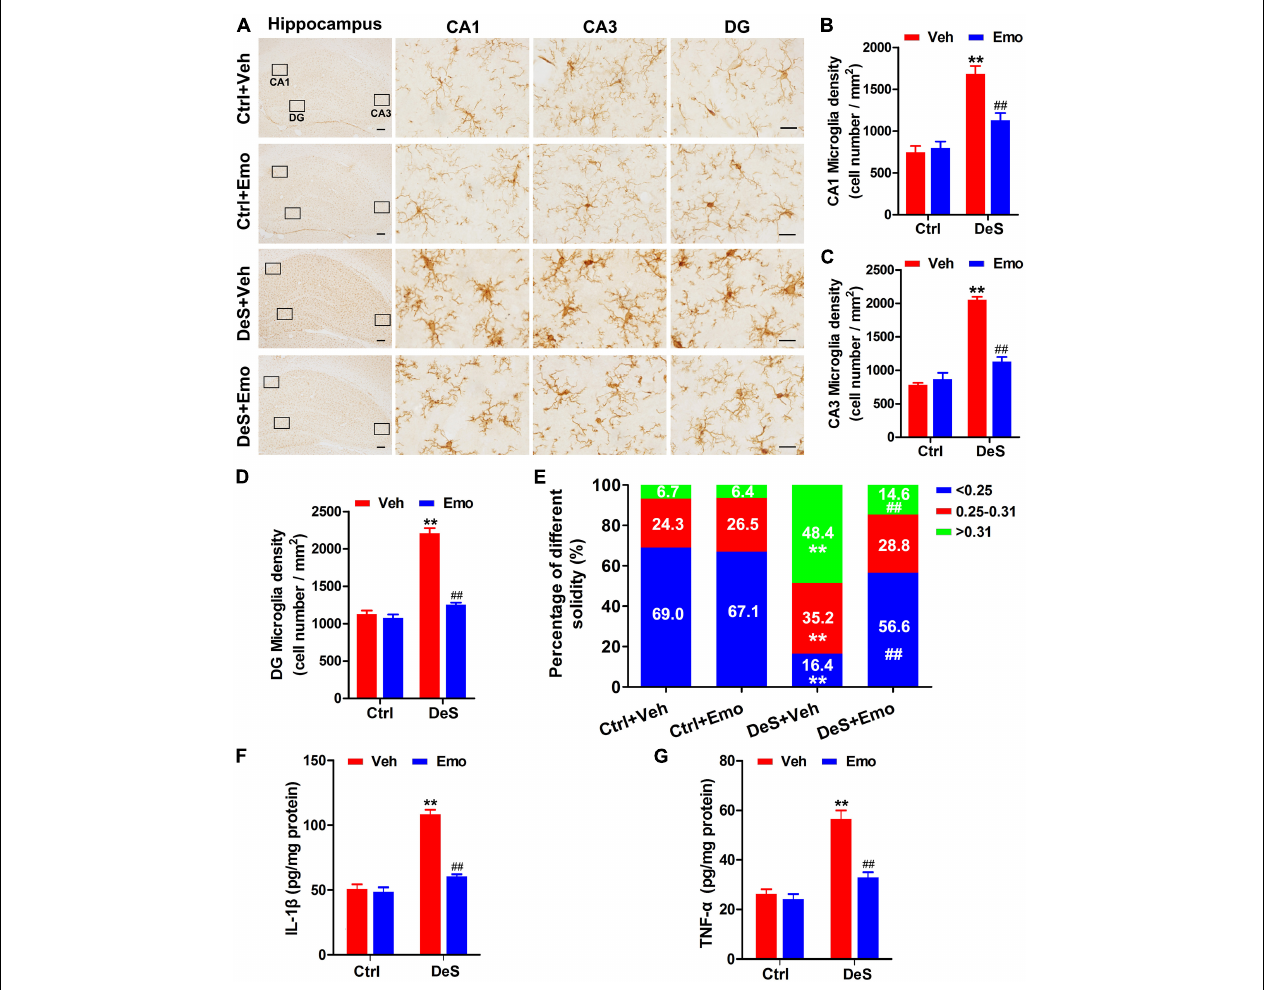
FIGURE 5 | Depression associated microglia activation was inhibited by emodin. By immunohistochemistry staining with Iba1 (a marker of microglia), hippocampal microglia were shown (A) (left scale bar = 200 µ m, right scale bar = 20 µ m). The densities of microglia in CA1 (B) [ F ( 3 , 8 ) = 27.088, p = 0.000], CA3 (C) [ F ( 3 , 8 ) = 82.790, p = 0.000] and DG (D) [ F ( 3 , 8 ) = 13.656, p = 0.000] regions were calculated ( n = 3 brains/group). The solidity value analysis was used to evaluate the activation of microglia. Higher solidity value indicated higher activity of microglia. The solidity values of the microglia were divided into three grades ( < 0.25, 0.25–0.31, > 0.31), and the percentages of microglia with different grades in different groups were shown ( E , n = 3 brains/group). By ELISA, hippocampal levels of interleukin-1 β (IL-1 β , F ) [ F ( 3 , 8 ) = 34.317, P = 0.000] and tumor necrosis factor- α (TNF- α , G ) [ F ( 3 , 8 ) = 22.465, P = 0.000] were assessed ( n = 3 brains/group). Data were analyzed by one-way ANOVA with LSD post hoc test and presented as means ± S.E.M. ** p < 0.01 DeS + Veh versus Ctrl + Veh, ## p < 0.01 DeS + Emo versus DeS +